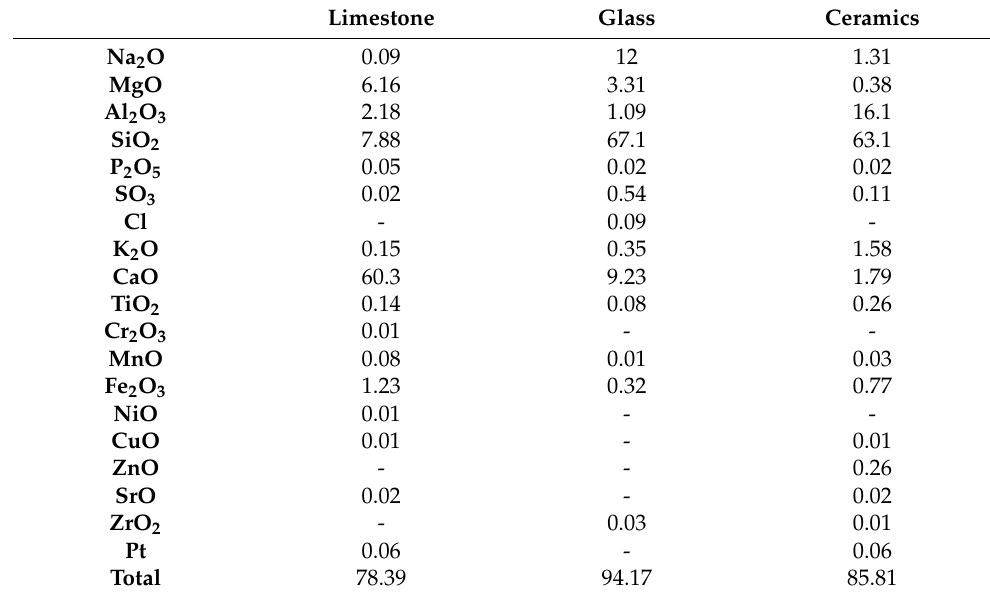
Table 1. Chemical composition of aggregates (%). Limestone Glass